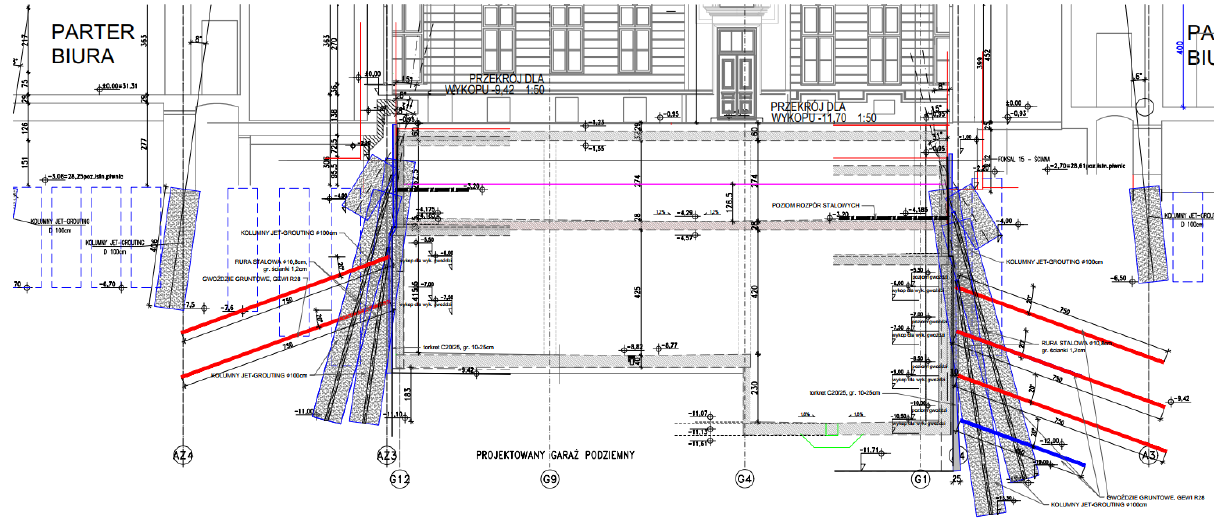
Figure 4. Cross section of the underground part of the